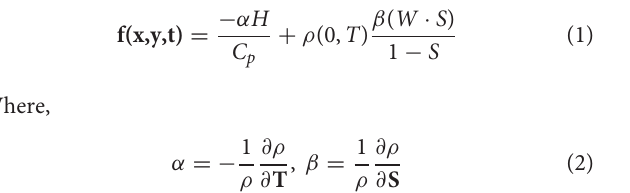
temperature were obtained to a depth of 1975 dbar in 58 levels (Gaillard et al., 2016; Kolodziejczyk et al., 2017). We use Argo ISAS datasets for SSS and SST as a reference by which we compare satellite-derived formation rates from SMOS SSS and OSTIA